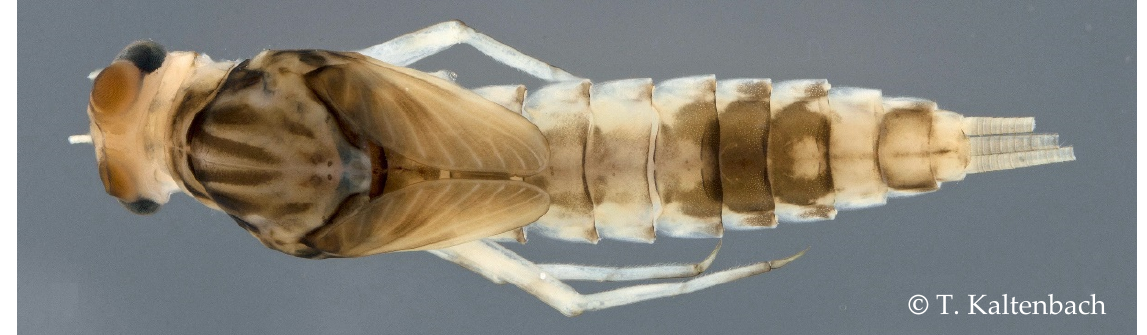
Figure 5. Habitus of Centroptilum cf. luteolum from the Rif.